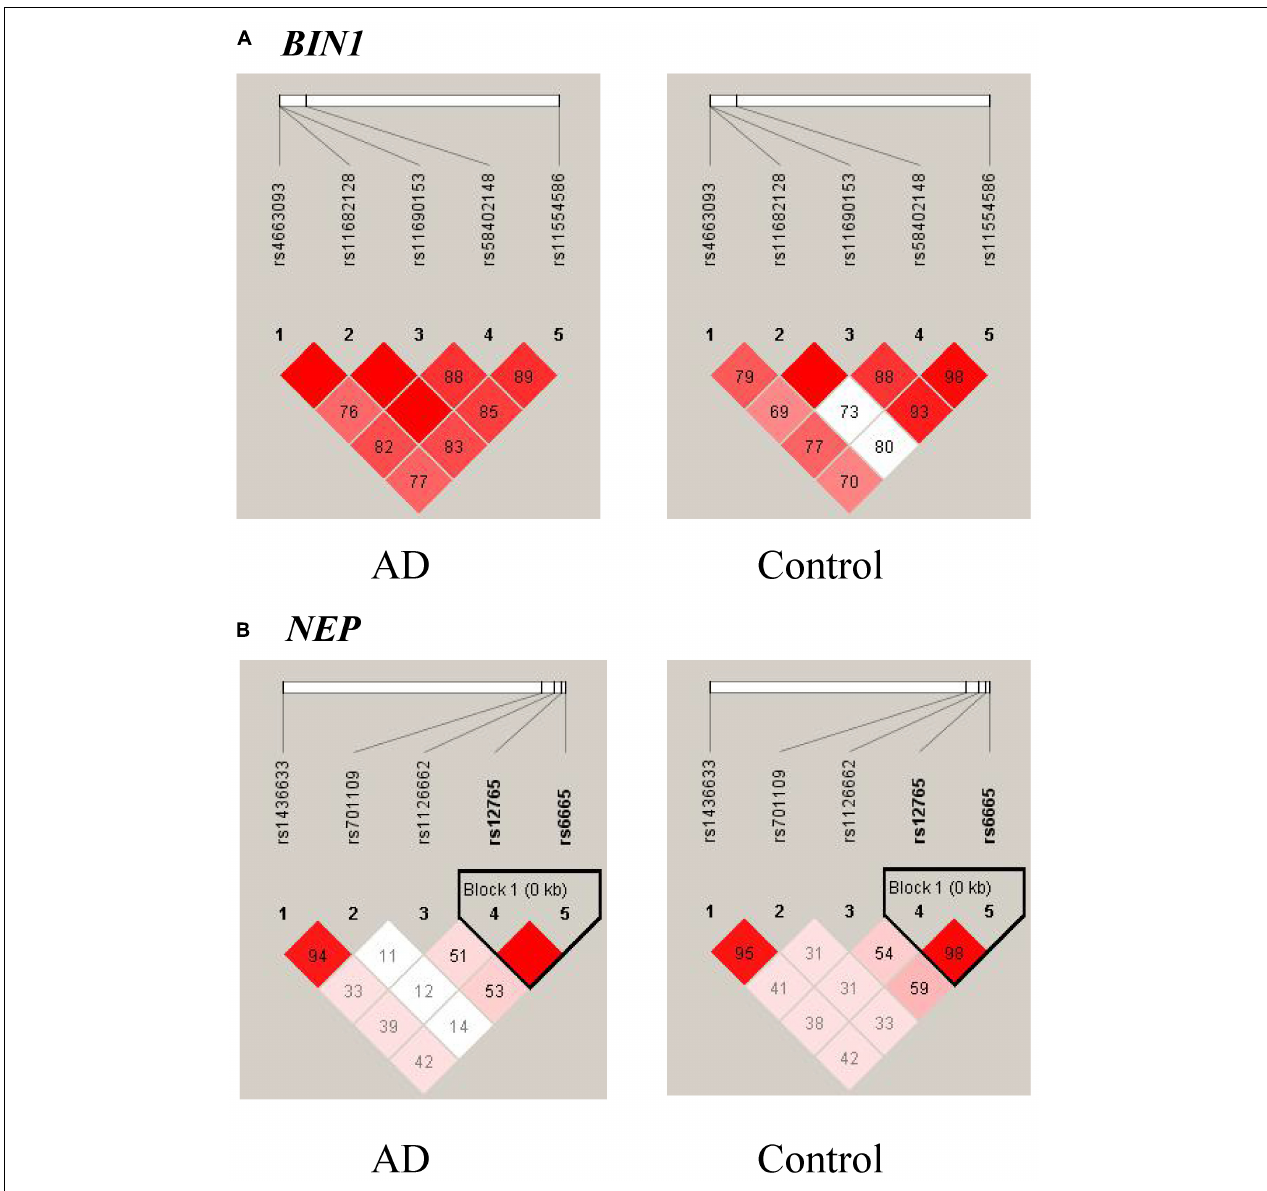
FIGURE 2 | Linkage disequilibrium (LD) patterns of BIN1 (A) and NEP (B) . The value in each square is equal to r 2 ×